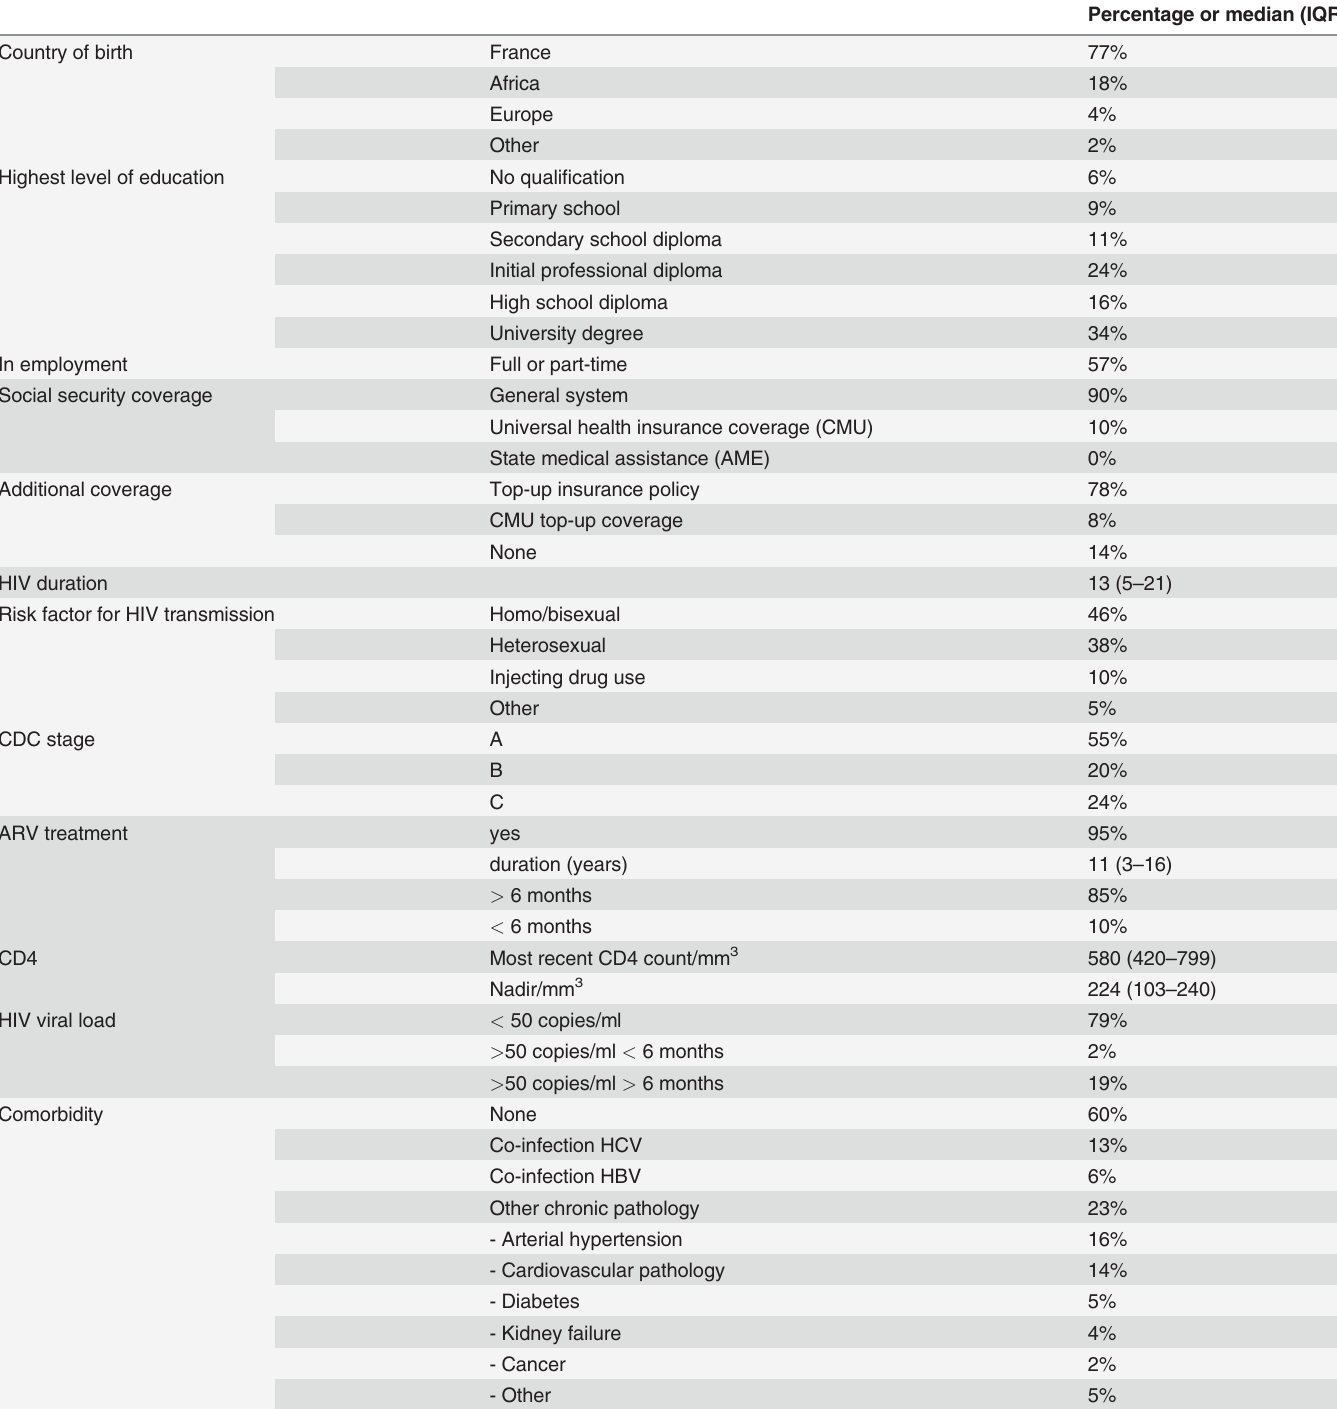
Table 1. Patients demographic and medical characteristics (N =